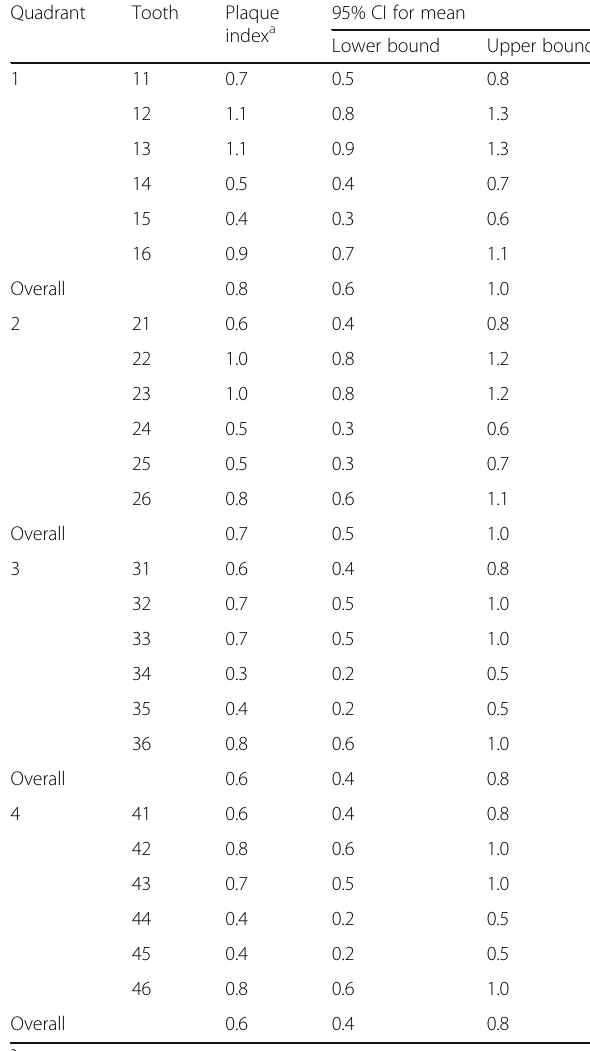
Table 1 Plaque index (PI) score of each tooth